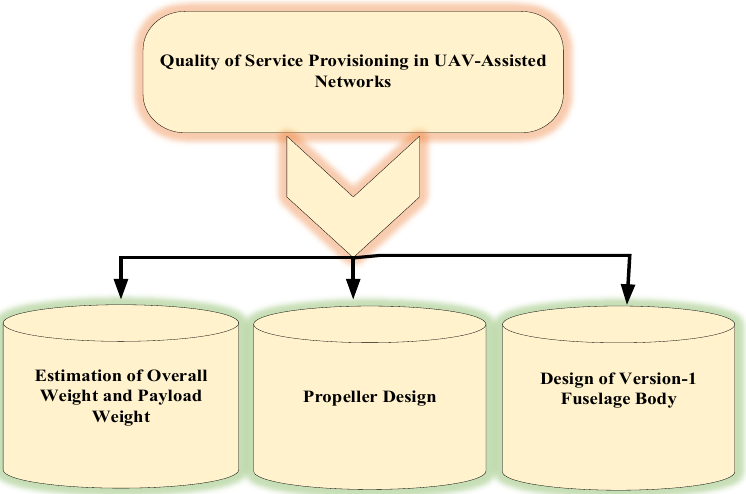
Figure 2. Main building blocks in quality-of-service provisioning in UAV-assisted networks. Table 2. Symbol Table.